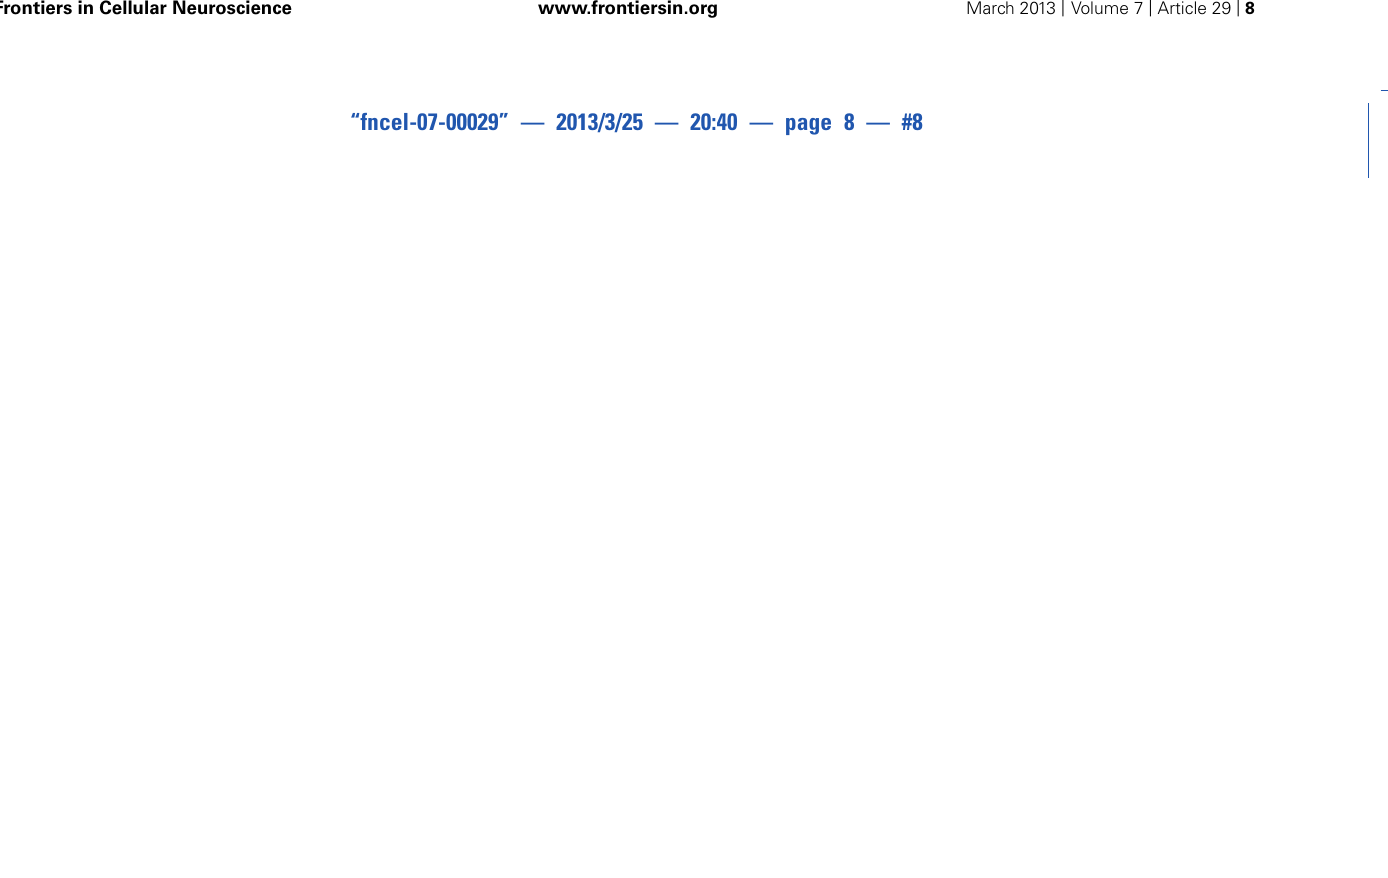
neurons require reprograming with genes, proteins or drugs, whereas ESCs and ONS cells do not. ONS cells and induced neurons may retain the methylation status of differentiated cells whereas ESCs and iPSCs do not. All methods introduce variability associated with cell culture but iPSCs and induced neurons may be more variable because of clonal selection due to the low efficiencies of the induction processes. ESC and ONS cell production average inter-clonal variation across large